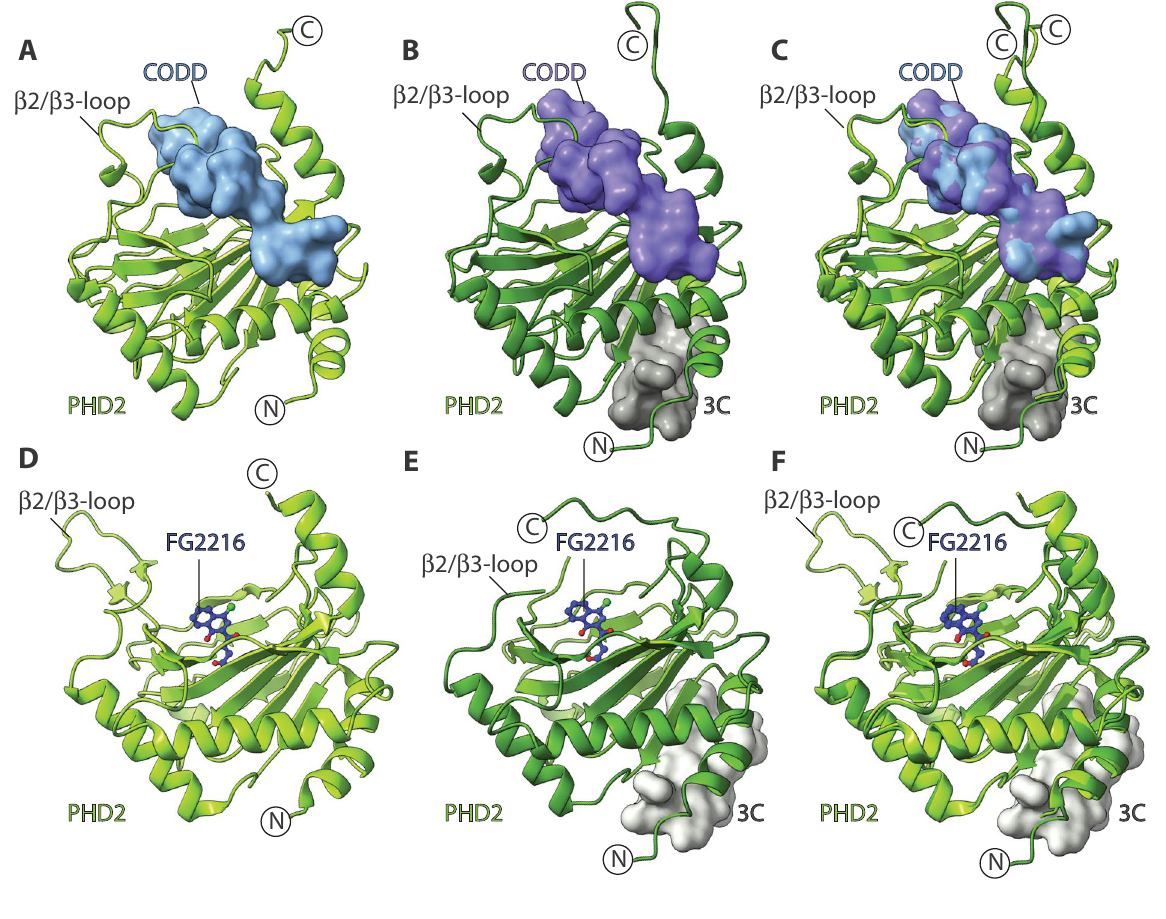
Figure 4. Comparison of PHD2.CODD and PHD2.FG2216 complexes in the presence and absence of 3C. The figure shows views from structures of nPHD2.CODD (PDB ID: 5L9B, A ), cPHD2.CODD.3C ( B ),